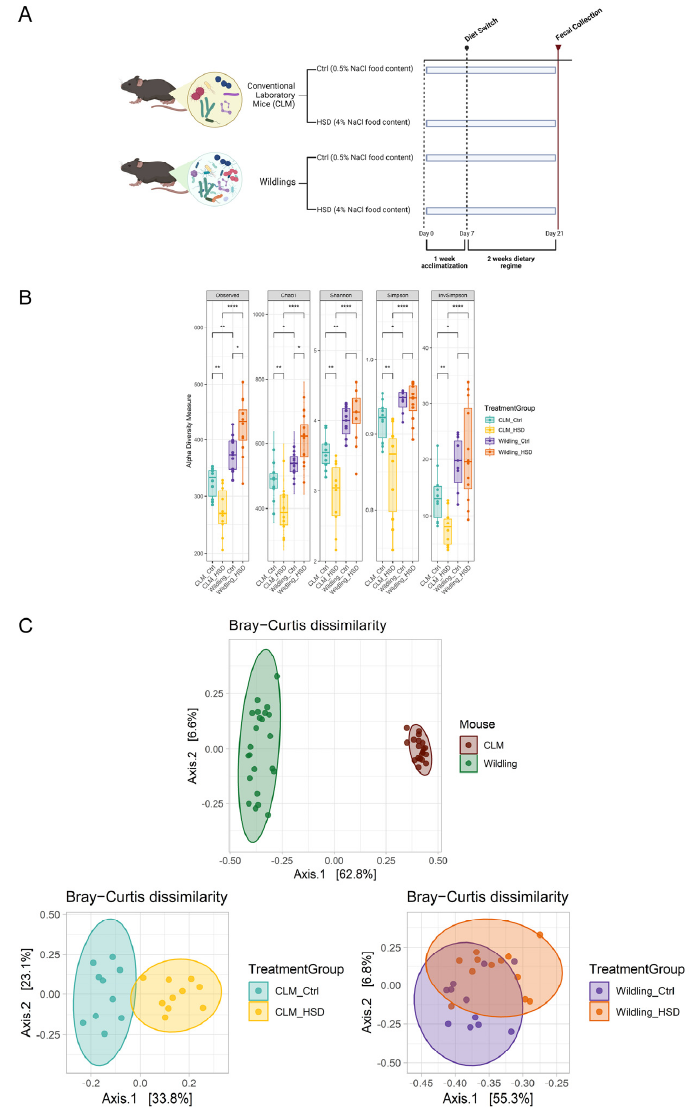
Figure 1. HSD impact on bacterial composition of CLM (n = 10/group) and wildling mice (n = 11 for wildling Ctrl and n = 12 for wildling HSD). ( A ) Experimental design. C57BL/6 CLM or wildling mice were fed on 0.5% NaCl (control, Ctrl) or high salt 4% NaCl (HSD) and gut bacterial community gut characterized by 16S rRNA gene amplicon sequencing. ( B ) Indexes for alpha diversity of fecal gut microbiota of CLM and wildling ; from left to right, the following indexes are shown: Observed (OUT richness), Chao1, Shannon, Simpson, InvSimpson (Inverse Simpson). Di ff erences between groups are evaluated statistically by Wilcoxon-test. ( C ) Principal coordinate analysis plot of beta diversity ordination from Bray − Curtis dissimilarity metric between CLM vs. wildling (top), CLM control vs. CLM HSD (bo tt om left) and wildling control vs. wildling HSD (bo tt om right); separation and homogeneity between groups was calculated by PERMANOVA and PERMDISP tests respectively.